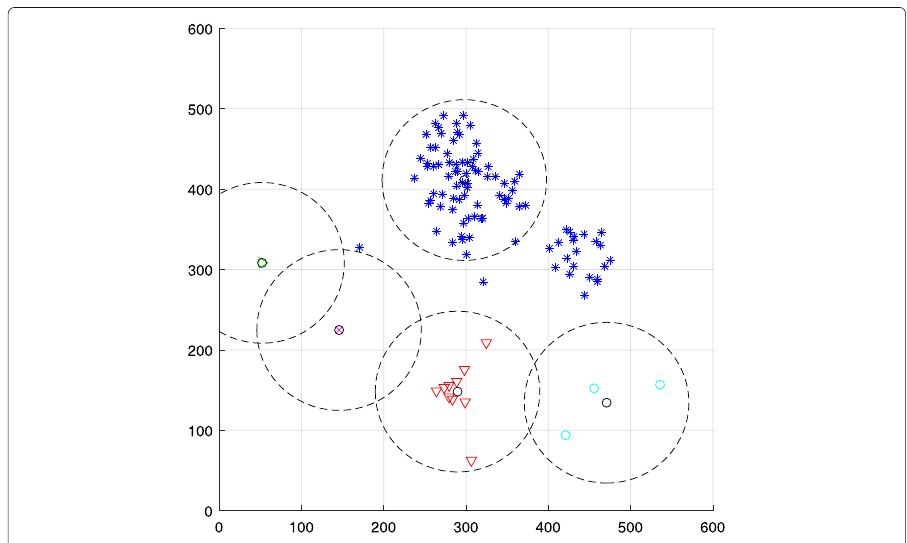
maximum scattering area, but the clustering performance of the clusters corresponding to the scattering area with a smaller radius is poor. The results of mean shift clustering are shown in Fig. 5, in which the dashed circle represents the size of the clustering window. The fixed-size sliding window does not have a good clustering effect when the difference in the radius of the scattering area is too large, and some points are even not classified into the